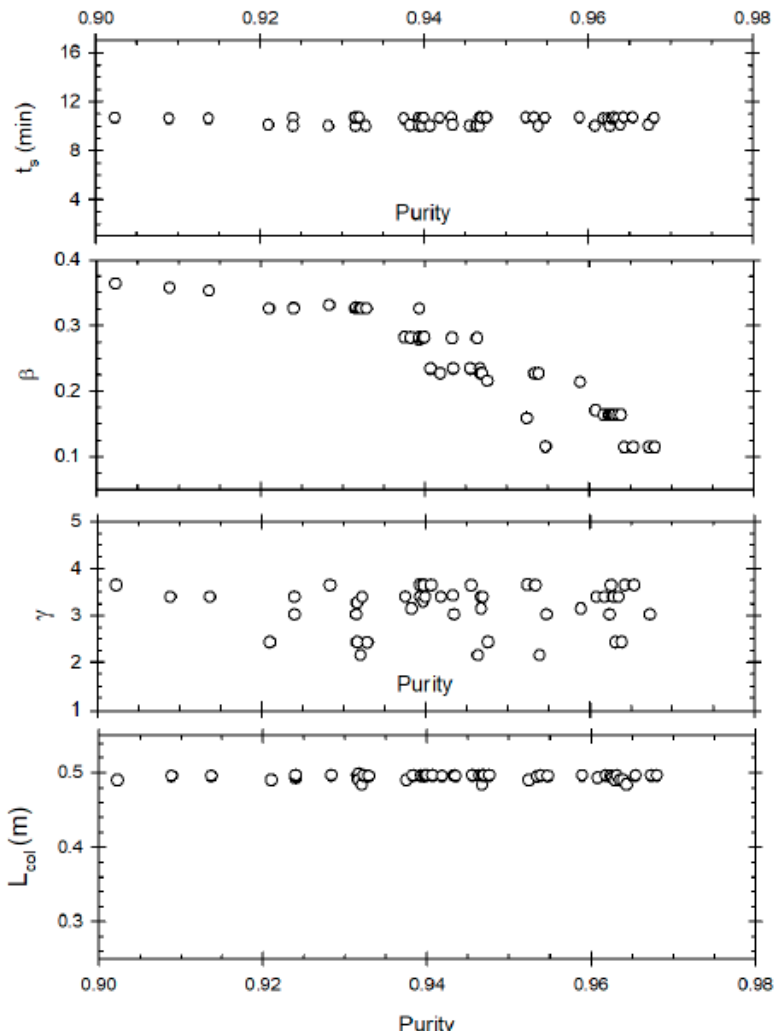
Figure 6. Case 2.1 Design-stage Optimization. Maximization of Yield and Purity. Corresponding operating variables for Pareto solutions shown in Figure 5.